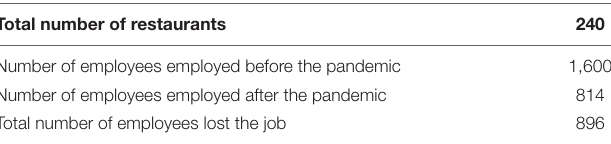
TABLE 2 | Employment status before and after the pandemic in the restaurants of the study area. Total number of